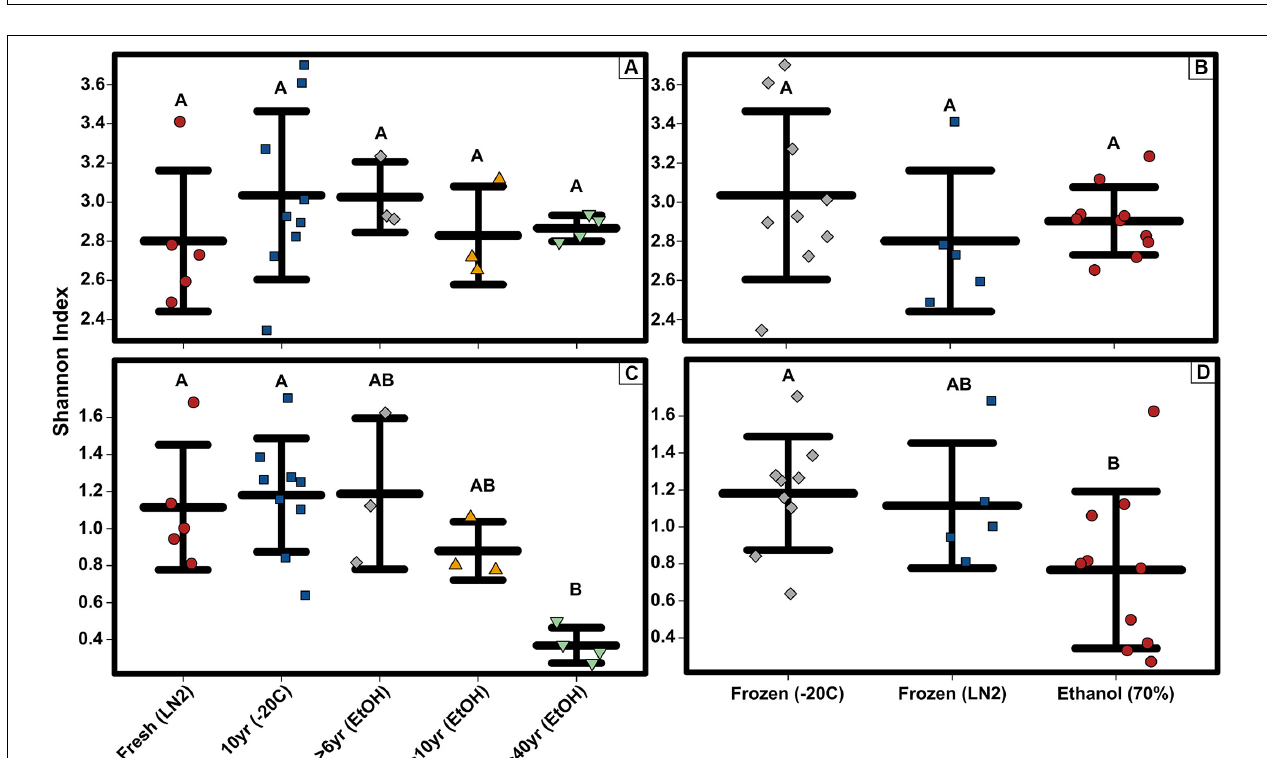
microbial community composition varied based on sample age (r 2 = 0.391, P < 0.001) and preservation type (r 2 = 0.208, P < 0.005). A test for homogeneity of variance was significant